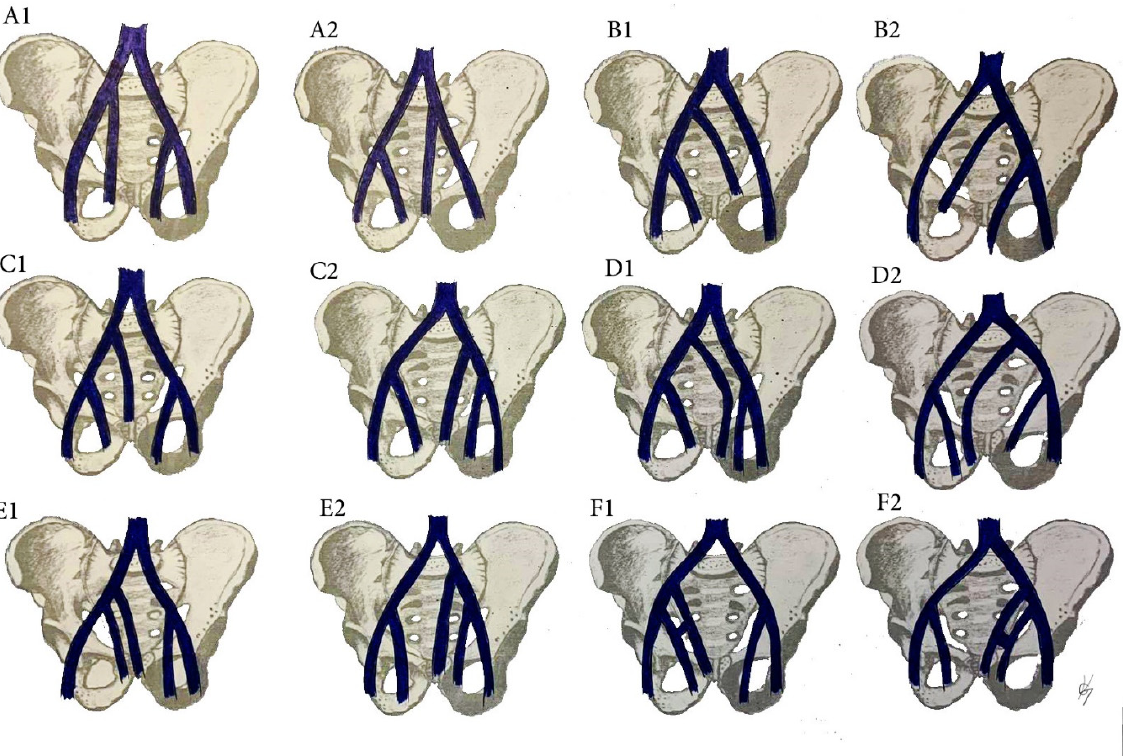
Figure 17. IIV variations. ( A1 ) high joining of the IIV to the ipsilateral EIV. ( B1 ) Joining of the IIV to the contralateral CIV. ( C1 ) Separated trunk of the IIV drains into the ipsilateral CIV. ( D1 ) separated trunk of the IIV drains into the contralateral CIV. ( E1 ) Duplication of the IIV. ( F1 ) Duplication of the IIV with a venous connection between them. Variations 1 are related to right pelvic sidewall, whereas variations 2 are related to the left pelvic sidewall.